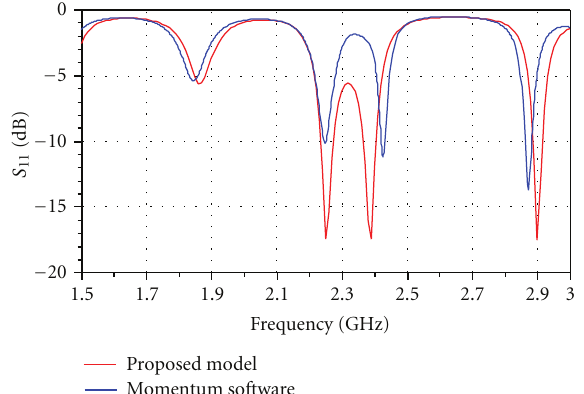
Figure 5: Simulated input antenna array return loss.